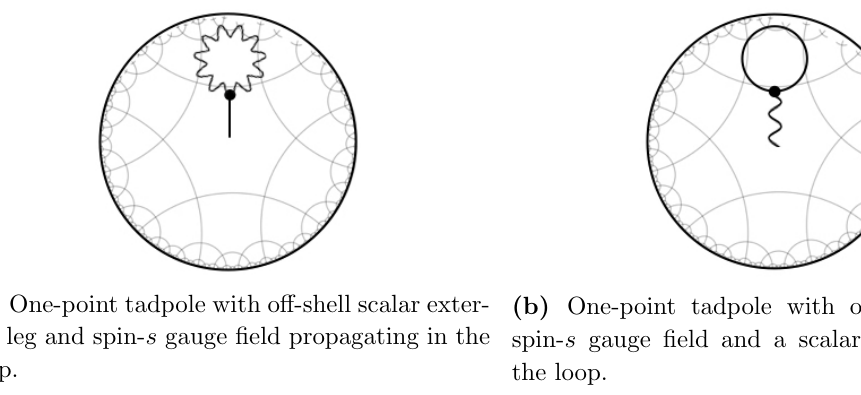
Figure 8. One-point tadpole diagrams involving a spin- s (cid:12)eld and a scalar